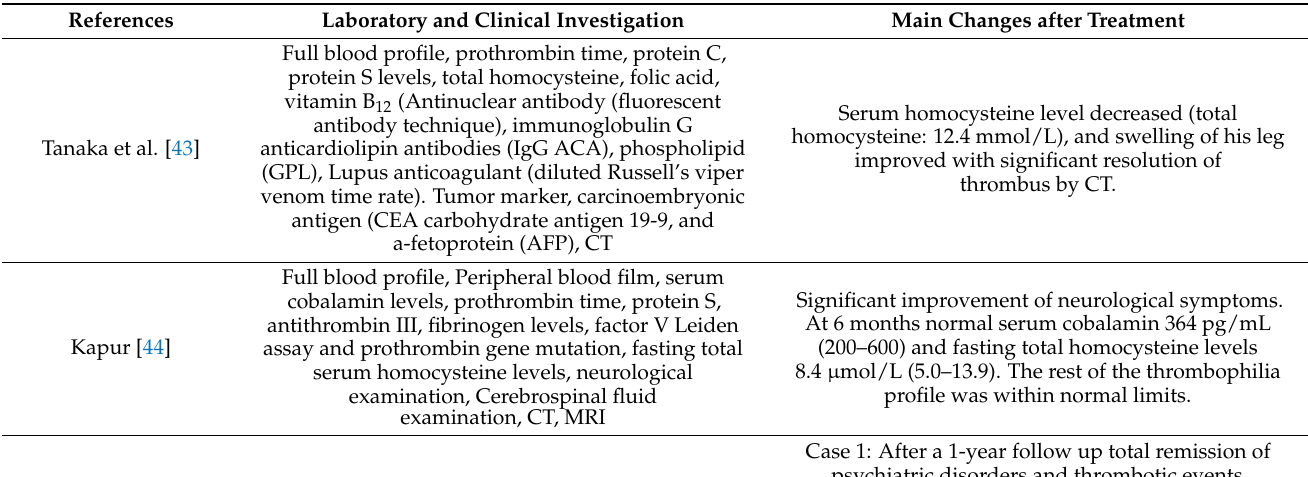
Table 3. Laboratory and clinical investigations of the reported cases in the section on vitamin B 12 deficiency and HHcy, with main changes after